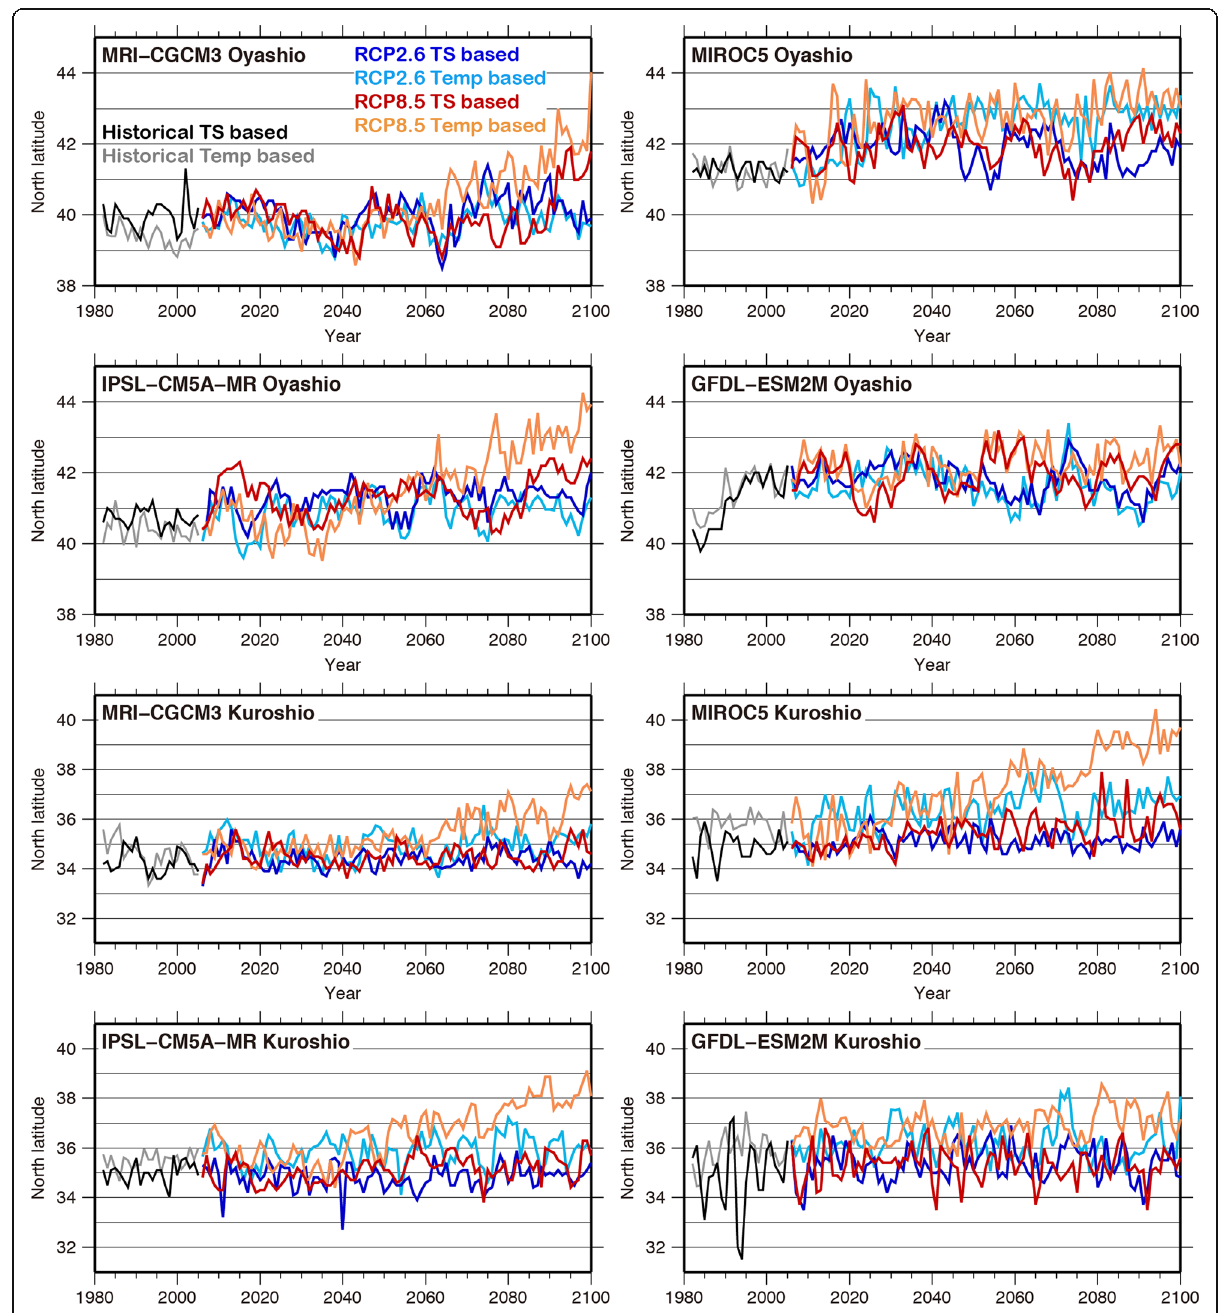
Fig. 7 Time series of the April – May mean Oyashio and Kuroshio fronts latitude from RCP2.6 and RCP8.5 scenarios of four models. Black (gray) curves are TS-based (temperature-based) latitude of historical simulation from 1982 to 2005. Blue (light blue) curves are TS-based (temperature- based) latitude of RCP2.6 simulation from 2006 to 2100. Red (orange) curves are TS-based (temperature-based) latitude of RCP8.5 simulation from 2006 to